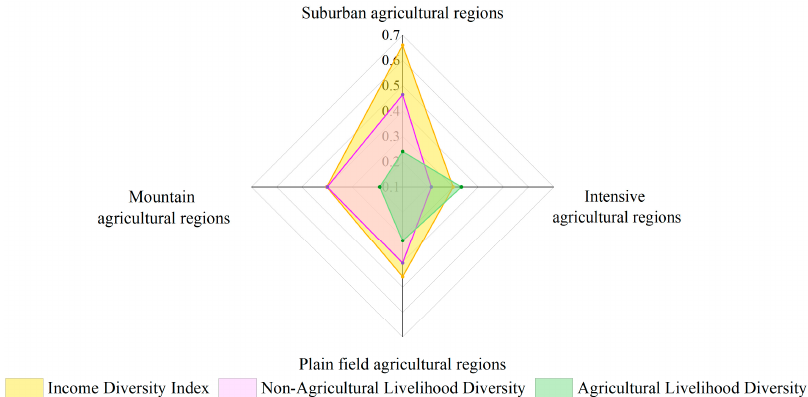
Figure 3. Comparison of livelihood diversity per household in different agricultural regions.